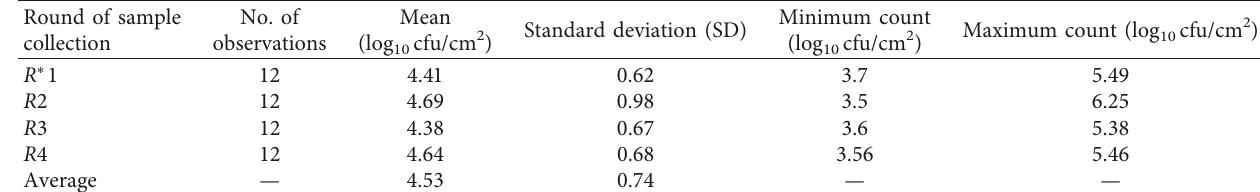
Table 3: Aerobic plate counts from abattoir in (log